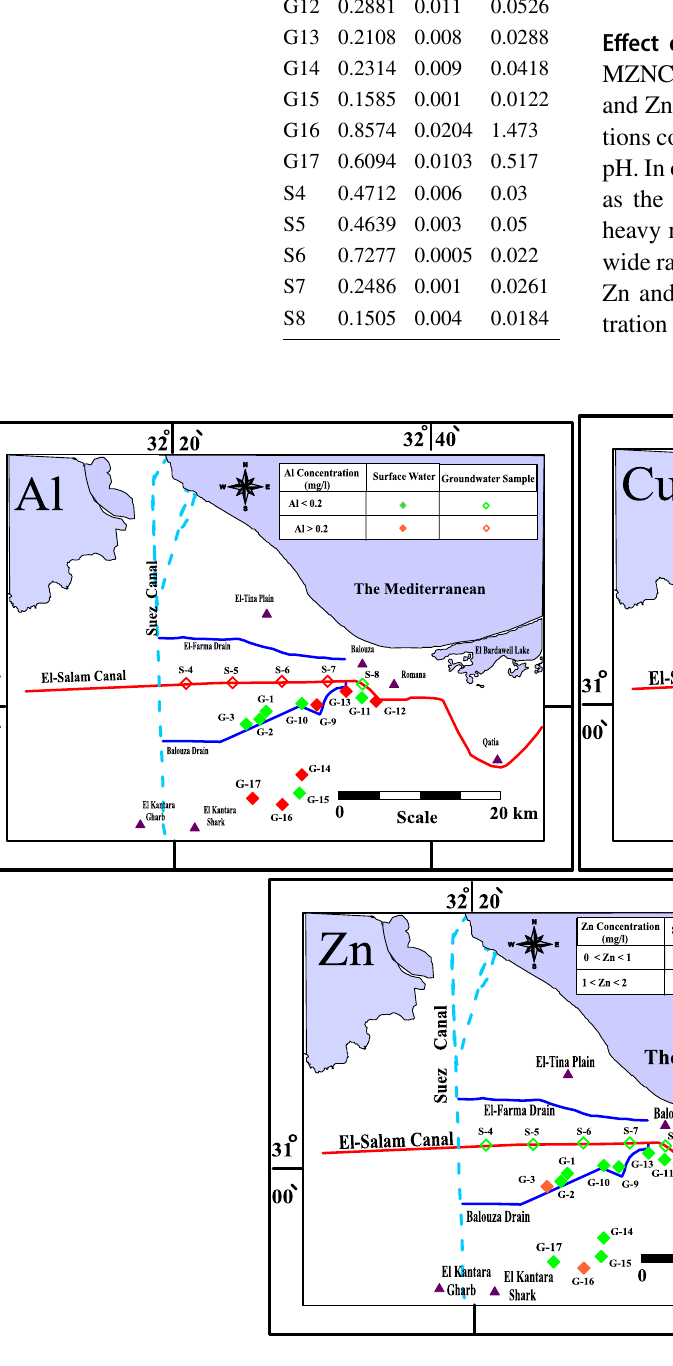
Fig. 7 Distribution of Al, Cu and Zn in surface and groundwater adjacent to El-Salam